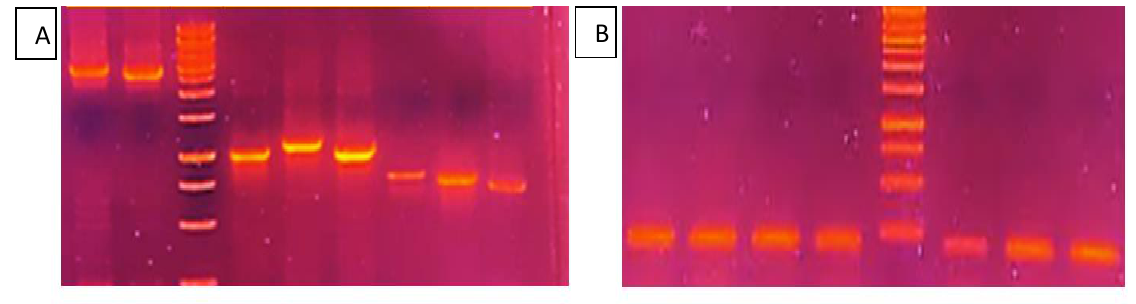
Figure 3. Ethidium bromide-stained agarose gel electrophoresis for detection of: A) IntI 1 IVRS amplicon products. Lane 3 represents the DNA ladder (1000 bp). Lane 1 and 2 show band size 2500bp, while lanes 4, 5 and 6 showed bands around 1000 bp in s size. Lanes 7, 8 and 9 showed bands of 750 bp in size. B) IntI 2 IVRS amplicon products. Lane 5 represents the DNA ladder (1000 bp). Lane 1, 2, 3, 4, 6, 7 and 8 show band size 250